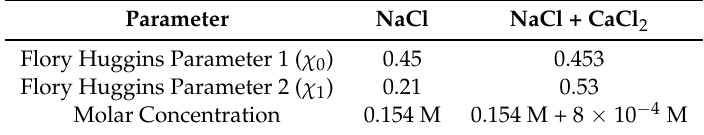
Table 1. List of parameters dependent on the external solution and their associated values.